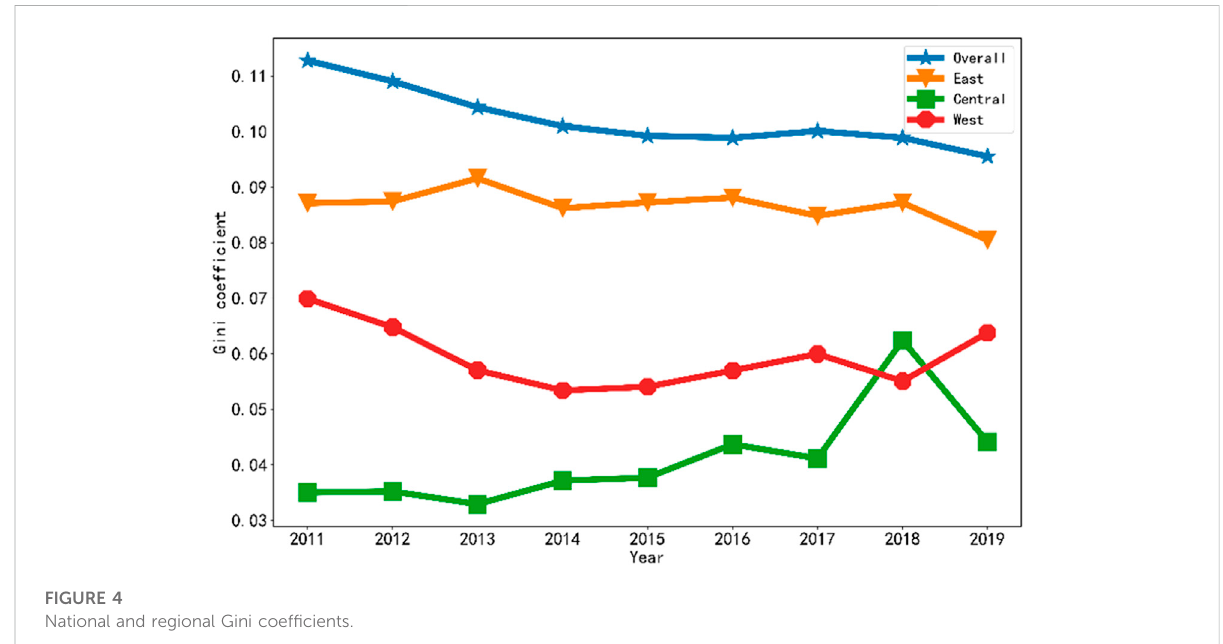
FIGURE 4 National and regional Gini coef fi cients.